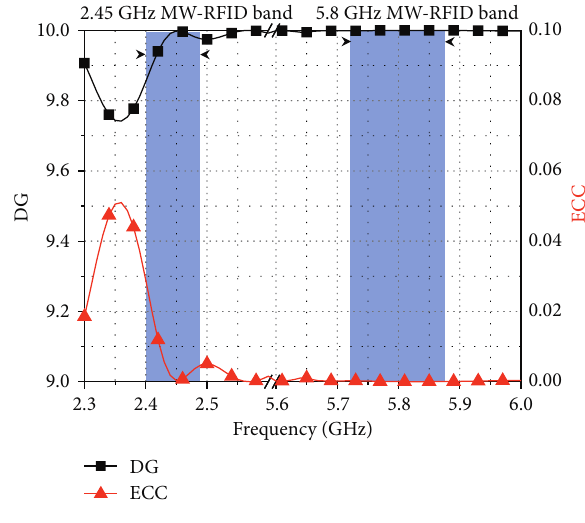
Figure 16: Calculated ECC and